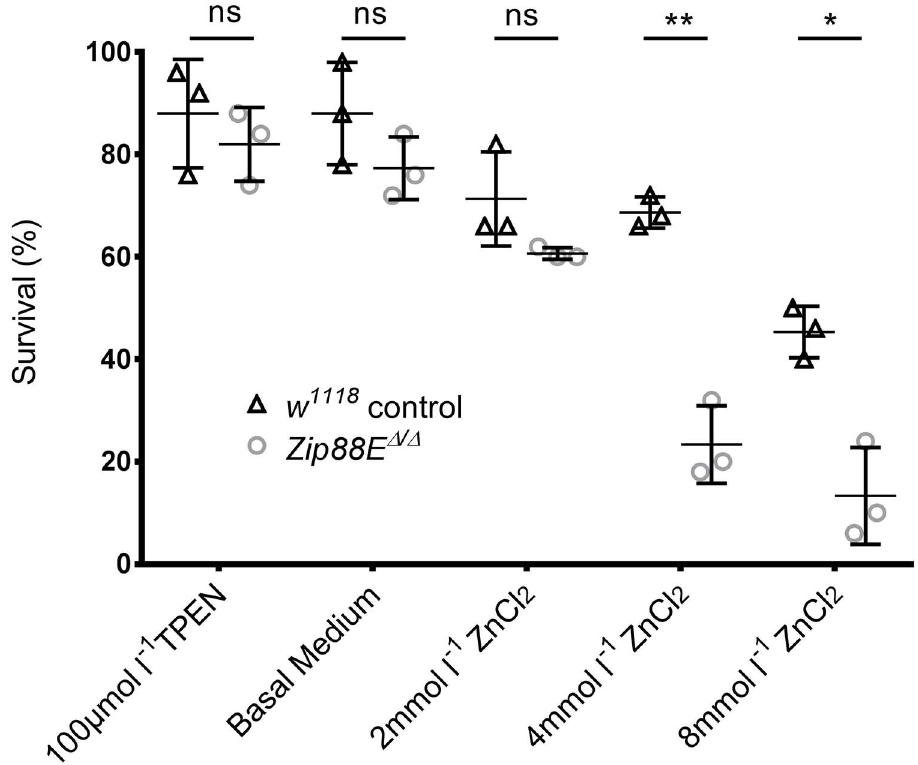
Fig 2. Larvae lacking Zip88E have increased susceptibility to high dietary zinc. Mean survival rates of control ( w 1118 ) and Zip88E Δ / Δ flies raised from first instar larvae on zinc-supplementedand zinc-chelated media. There is no effect on survival of Zip88E Δ / Δ flies on basal, zinc-chelated (TPEN) and 2 mmol l -1 ZnCl 2 - supplemented media comparedto control flies. Zip88E Δ / Δ flies have a significantly decreasedsurvival rate on 4 and 8 mmol l -1 ZnCl 2 -supplemented media comparedto control flies (valuesare representedas the mean ± SD and comparedby multipleunpairedT-test: *** P (cid:20) 0.001, **** P (cid:20) 0.0001, n =